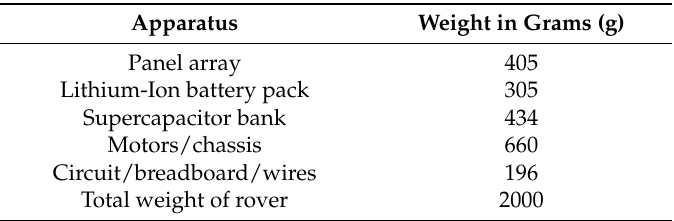
Table 1. Weight and weight distribution of the